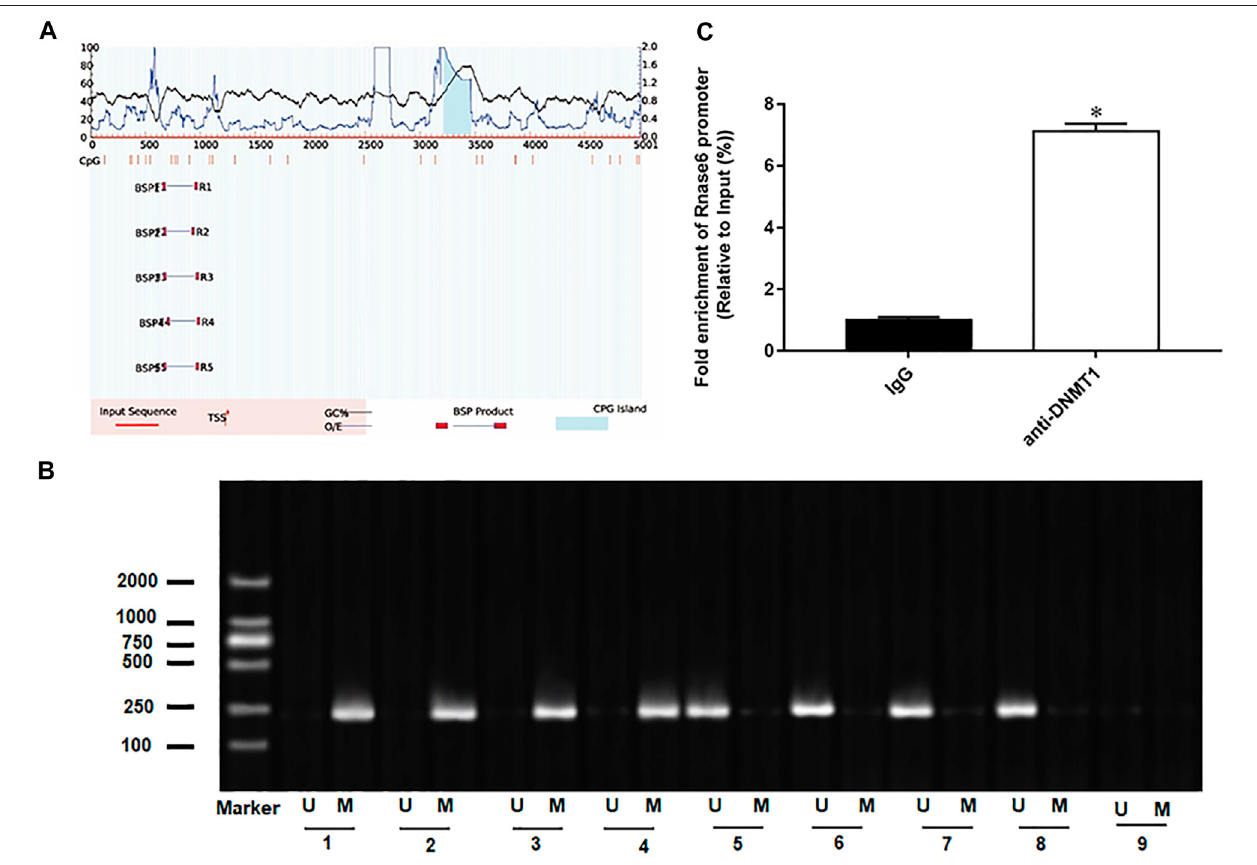
FIGURE3| ThepresenceofCpGislandsinthepromoterregionofRnase6. (A) .Cutting5,000bpupstreamofthetranscriptionstartsiteofmouseRnase6geneas the promoter region, the distribution of CpG islands in the promoter region of Rnase6 gene was analyzed online using methylation prediction software (http://www. urogene.org/methprimer2/). (B) . MSP was used to detect the methylation status of Rnase6 in peripheral blood of healthy volunteers and patients with atherosclerosis. 1 – 4: healthy volunteers; 5 – 8: atherosclerosis patients; 9: blank control; U: unmethylated; m: methylated. (C) . Chromatin immunoprecipitation (ChIP) was used to verify the binding relationship between Rnase6 and DNA methyltransferase 1. N (cid:2) 6, * p <